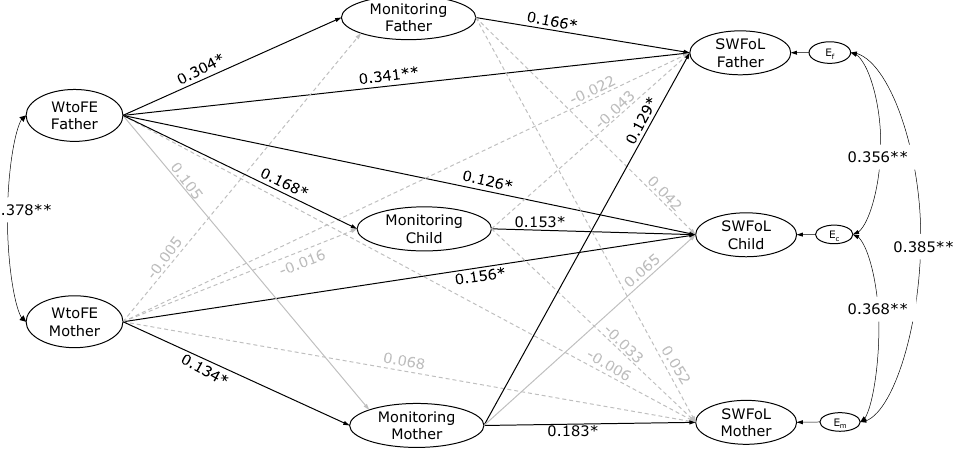
Figure 2. Actor–partner interdependence model of the effect of parents’ work-to-family enrichment (WtoFE) on the three family members’ monitoring (the perception regarding parents’ monitoring practices in adolescents) and satisfaction with food-related life (SWFoL) in dual-earner parents with adolescent children. E f , E c and E m : residual errors on SWFoL for the fathers, mothers and their adolescent children, respectively. * p < 0.05, ** p < 0.01. The control for the effects of both members of the couple’s age, type of employment and their number of working hours as well as the family SES, the number of children and the number of supper times in which all the family members ate together during a week on the dependent variables of the three family members (monitoring and SWFoL), are not shown in the path diagram.